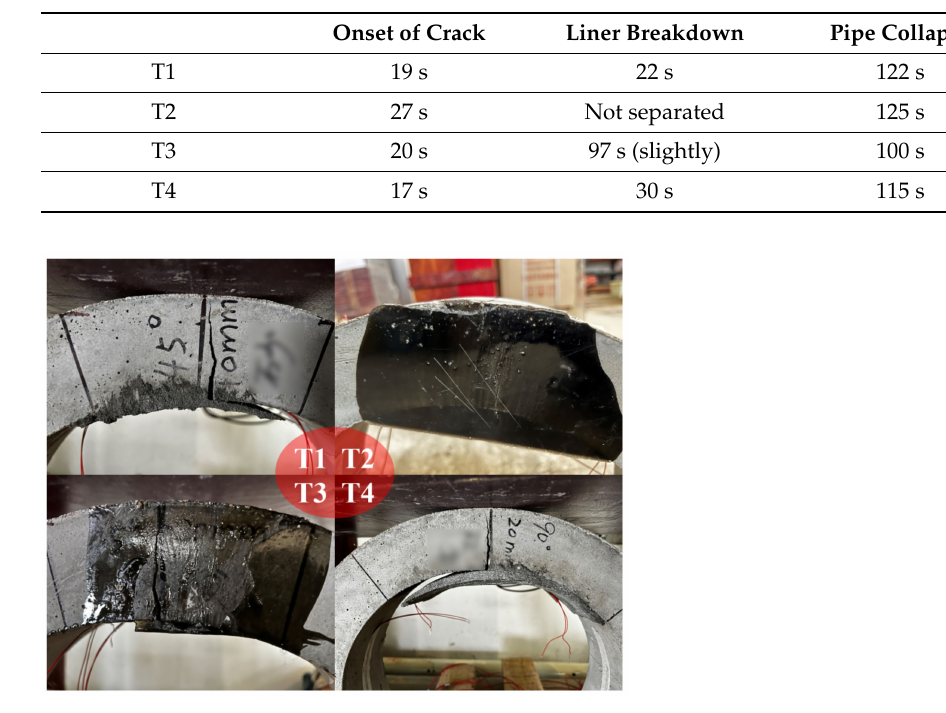
Figure 9. Liner–pipe interfaces after TEBTs of